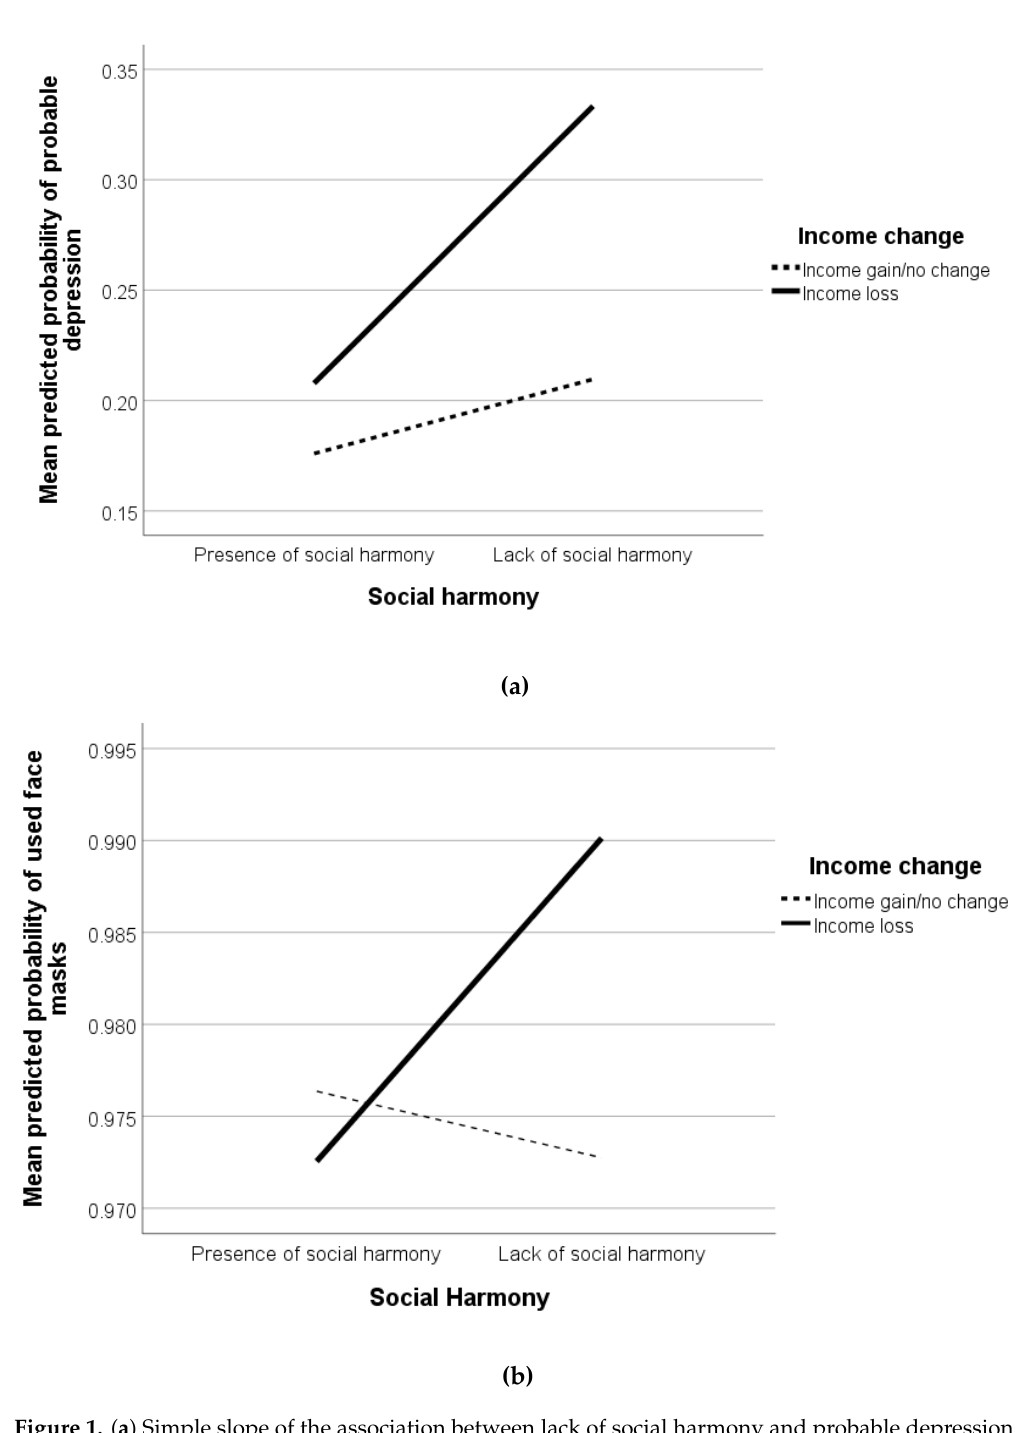
Figure 1. ( a ) Simple slope of the association between lack of social harmony and probable depression moderated by income change; ( b ) Simple slope of the association between lack of social harmony and used face masks moderated by income change.